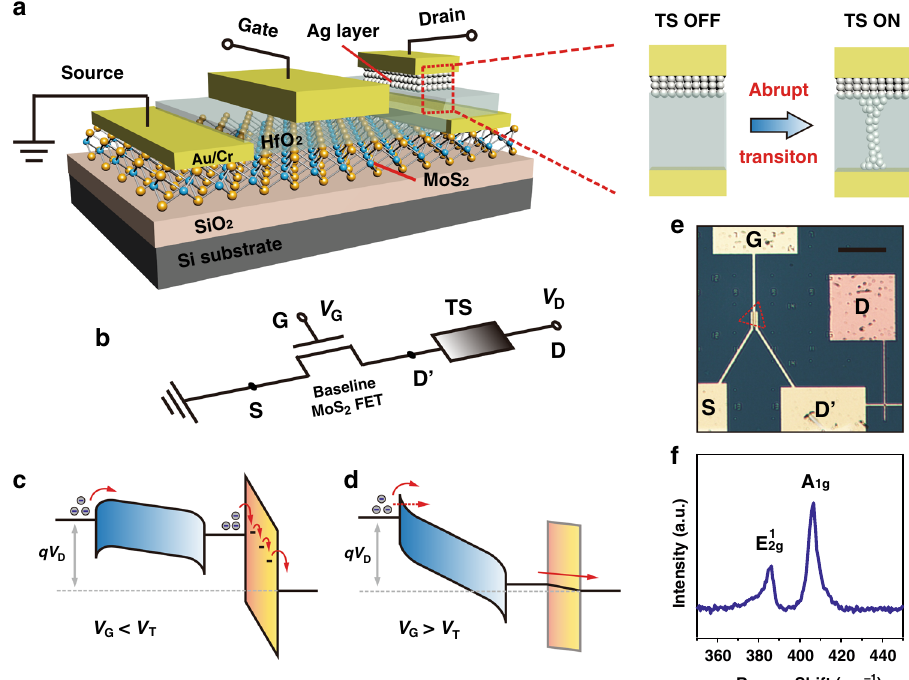
Fig. 1 Ultralow-power steep-slope 2D MoS 2 fi eld-effect transistor with Ag atomic threshold-switching (ATS-FET). a Schematic illustration of the ATS- FET, consisting of a MoS 2 FET and an Ag/HfO 2 based TS. The enhanced performance of the ATS-FET is essentially attributed to the abrupt switching transition of the TS. b The equivalent circuit schematic of the ATS-FET, which can be considered as a baseline MoS 2 FET in series with a TS device. V D is the drain-to-source voltage across the TS and the MoS 2 FET; V G is the gate-to-source voltage across the MoS 2 FET. c , d Schematic band diagrams of the ATS-FET under thermal equilibrium with V G bias, including c V G < V T and d V G > V T . Electrons pass through the contact barriers via thermionic emission or tunneling; and across the electrolyte barrier via hopping. e Optical image of the ATS-FET device structure, exhibiting that the TS stack (cross-point area: 2 × 2 μ m 2 ) in series with the channel of the MoS 2 FET. The red-dashed triangle indicates the MoS 2 channel material. Scale bar: 50 μ m. f Raman spectrum of the CVD synthesized MoS 2 nano fl ake. The peaks of in-plane E 2g and out-of-plane A 1g vibrational modes are at 386.2 and 406.6 cm − 1 ,